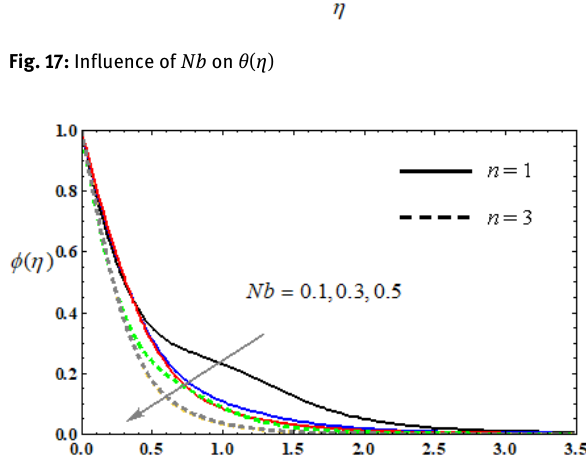
Fig. 17: Influence of Nb on θ ( η )